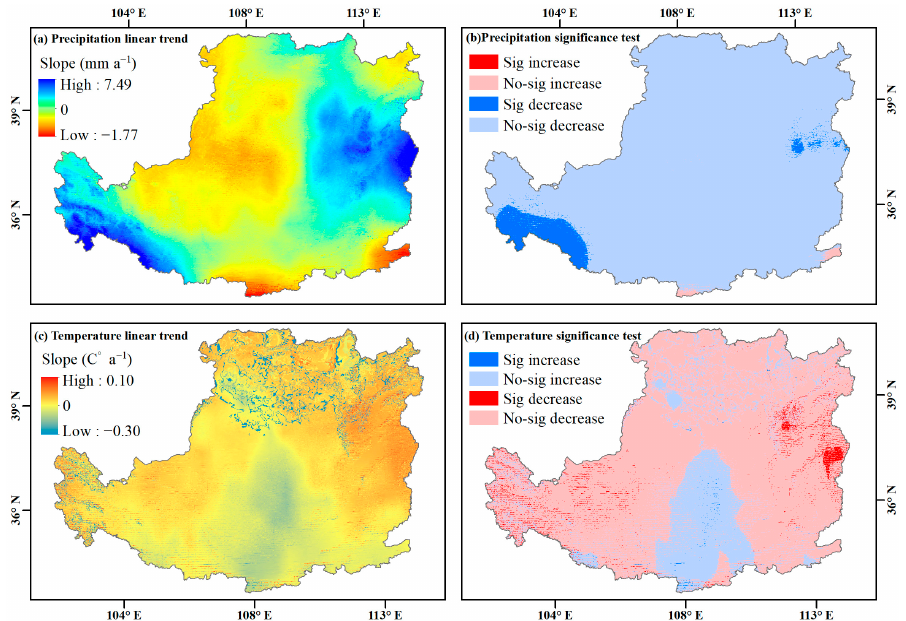
Figure 6. Trends in precipitation ( a ) and temperature ( b ) on the Loess Plateau and their spatial distribution of significance ( c , d ).